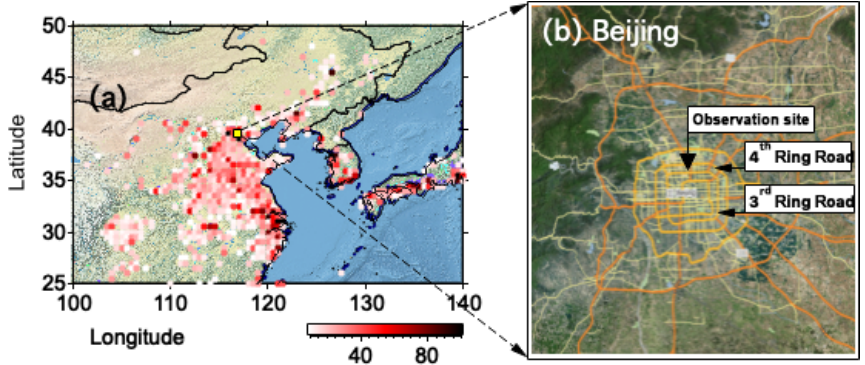
Figure 1. Geographic location of the observation site and NO x emission in East Asia (a) ; the transportation map of Beijing and location of the tower on the campus of the Institute of Atmospheric